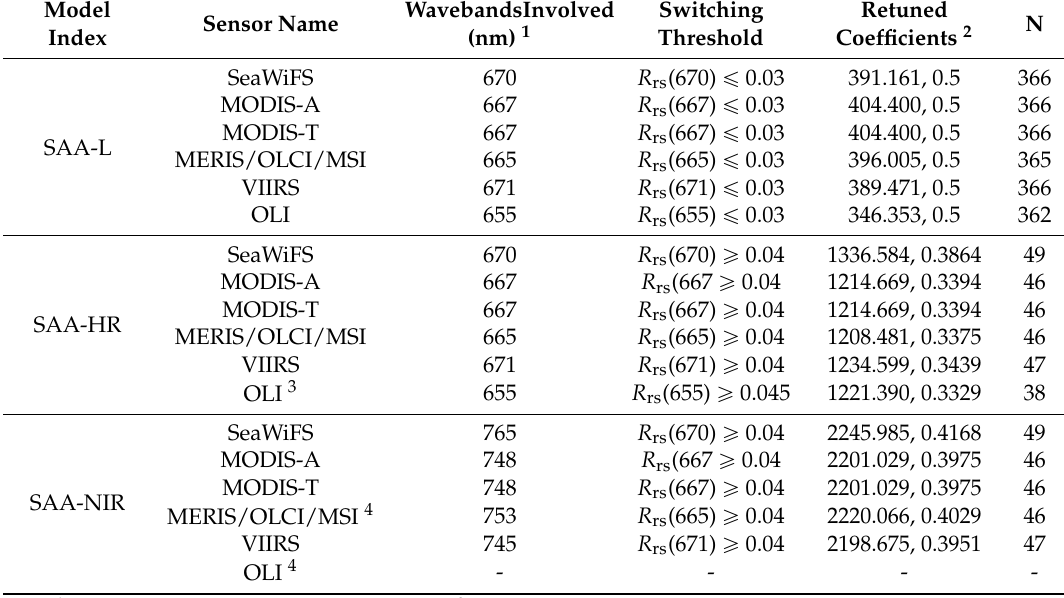
Table 5. Coefficients of the SPM-dependent models developed on DS-D for various Ocean Color sensors.